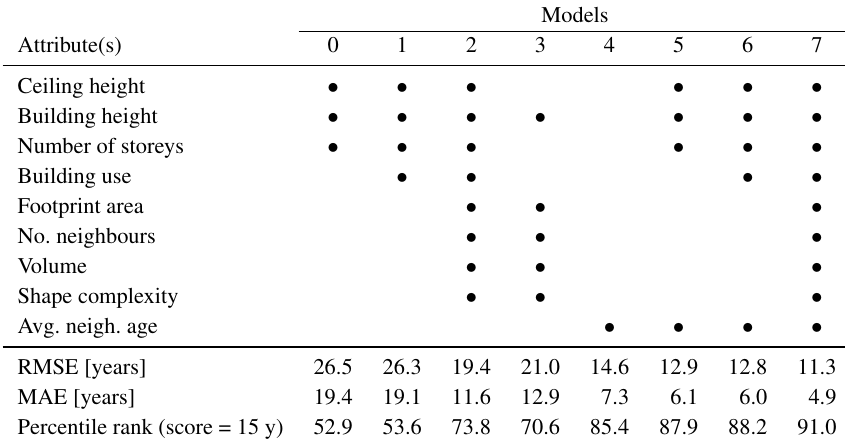
Table 1. Combinations of attributes and the performance (accuracy) of the predictive models.